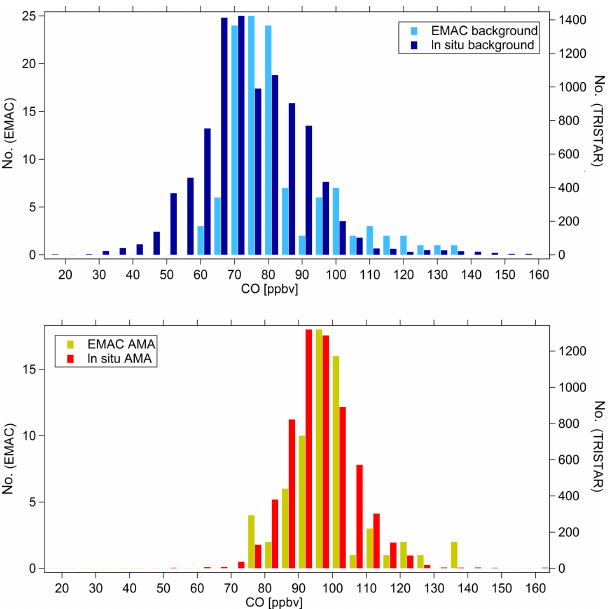
Figure 15. Histogram for in situ measured and EMAC modelled CO within the 300–140hPa altitude range, for both background and AMA air.